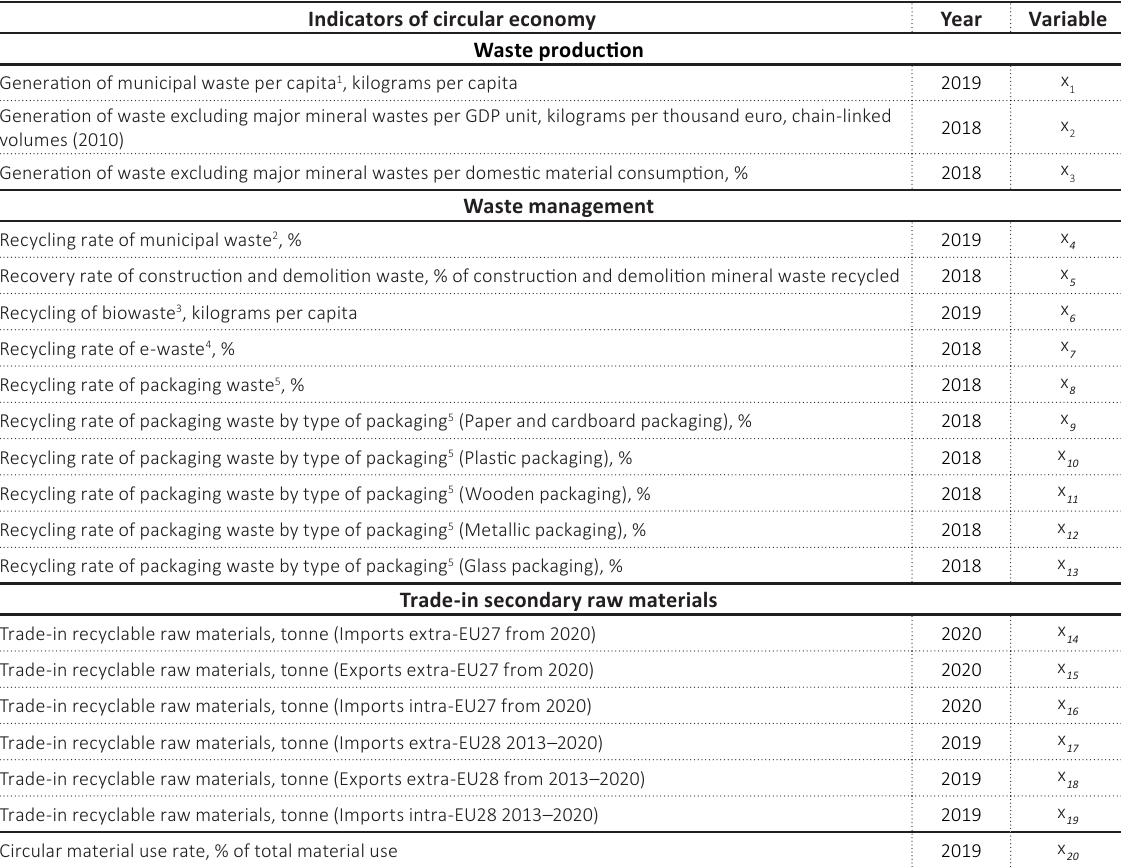
Source: Eurostat Database